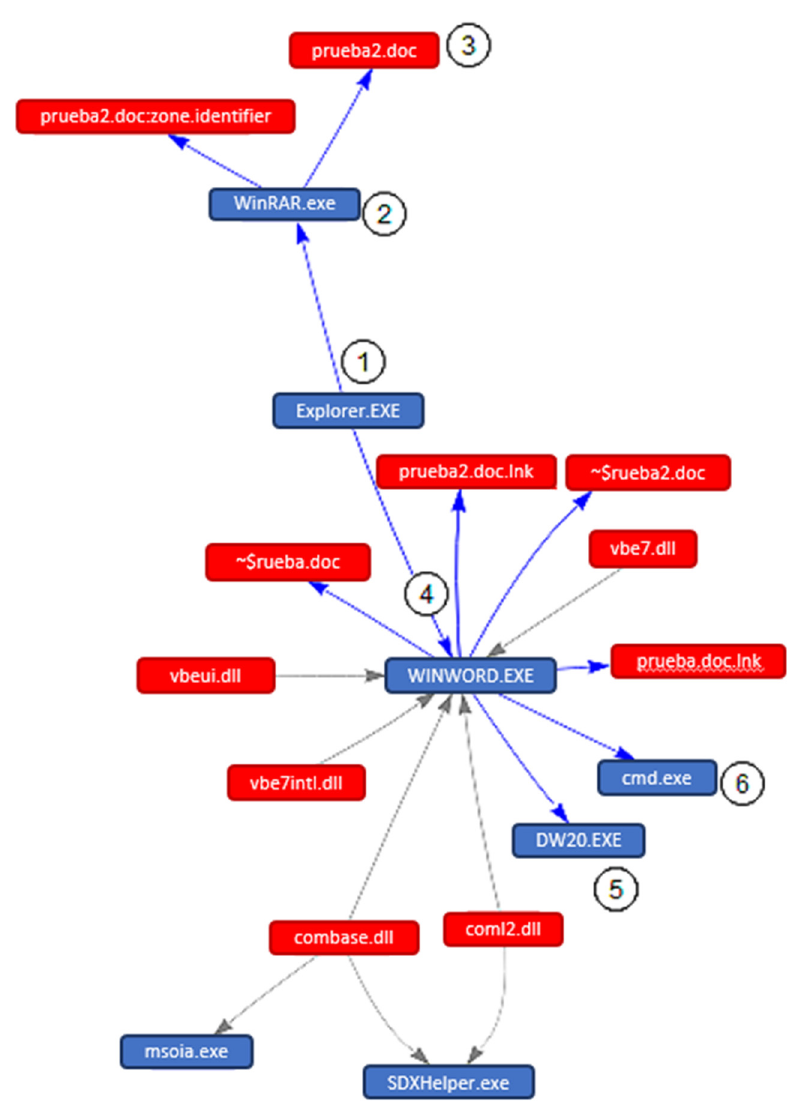
Figure 3. Result of malicious macro execution in a Microsoft Word document.